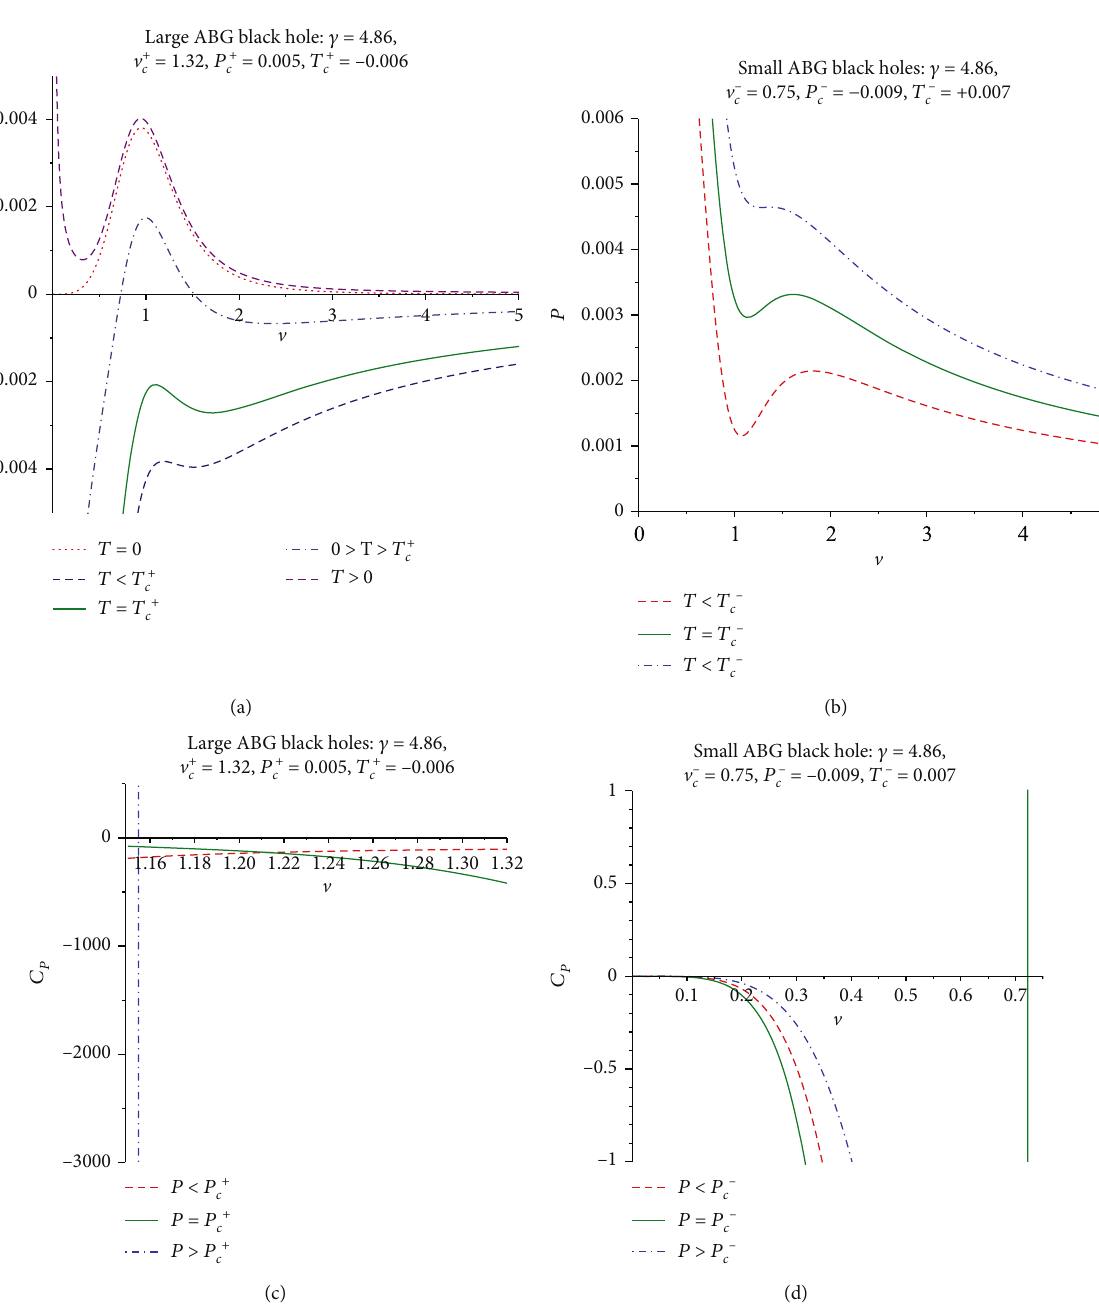
Figure 2: (a, b) P-V diagrams at constant temperatures for large and small generalized ABG black hole, respectively. (c, d) Heat capacity diagrams at constant pressure for large and small generalized ABG black holes,